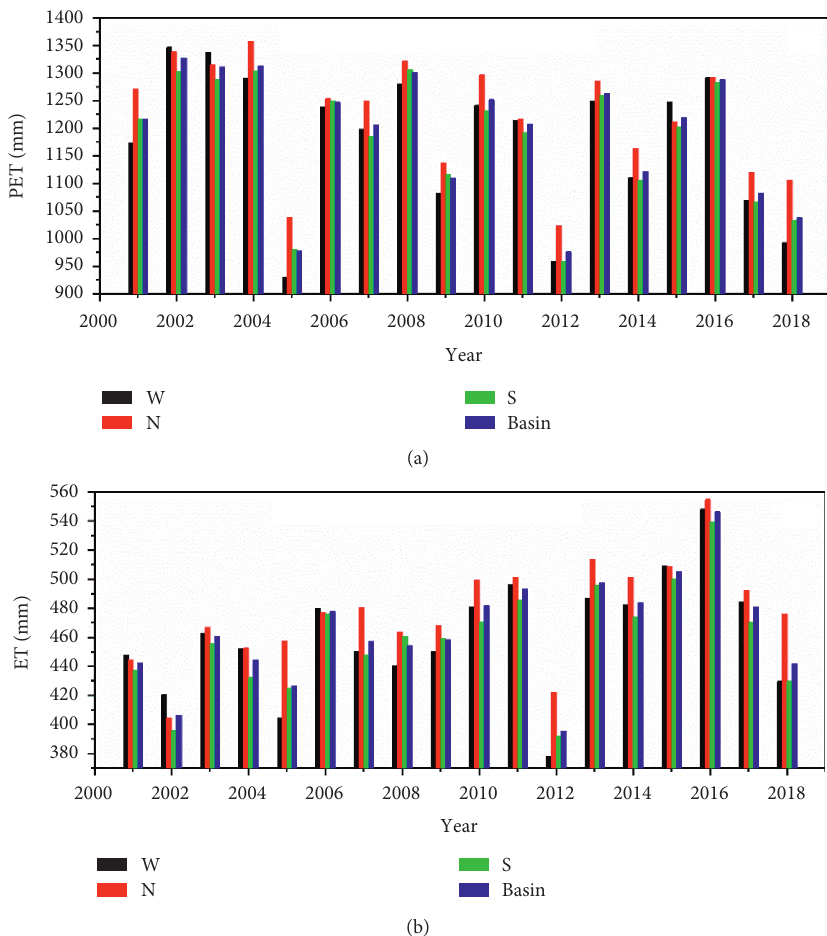
Figure 7: Temporal changes of annual PET (a) and ET (b) in whole basin and three subzones from 2001 to